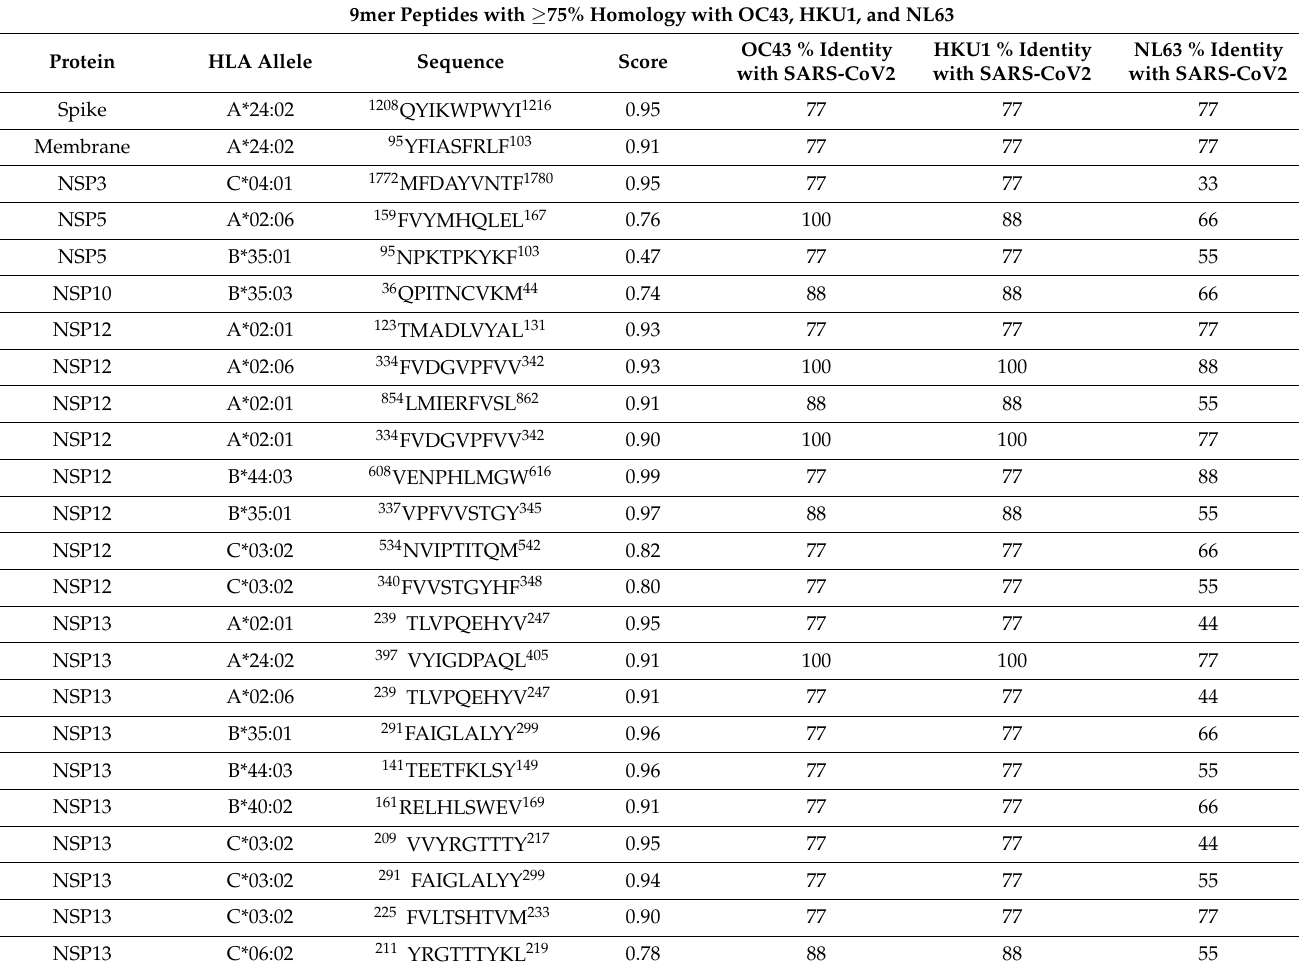
Table 4. Predicted CD8 + epitopes of the SARS-CoV2 virus, which show ≥ 75% homology with OC43, HKU1, and NL63. 9mer Peptides with ≥ 75% Homology with OC43, HKU1, and